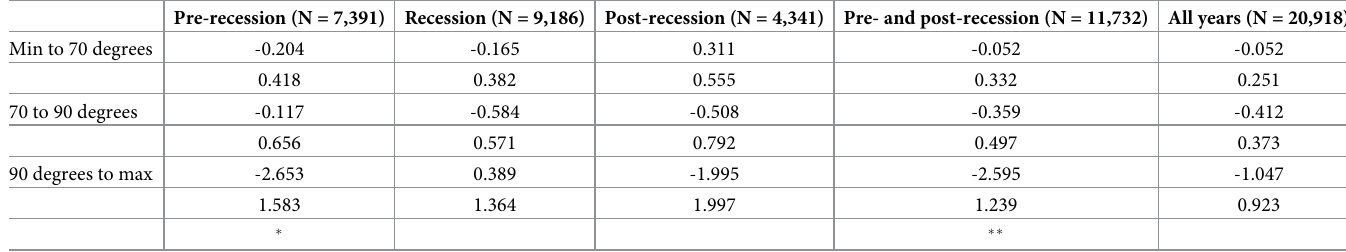
Table 2. Estimation results: All years and by recession/non-recession